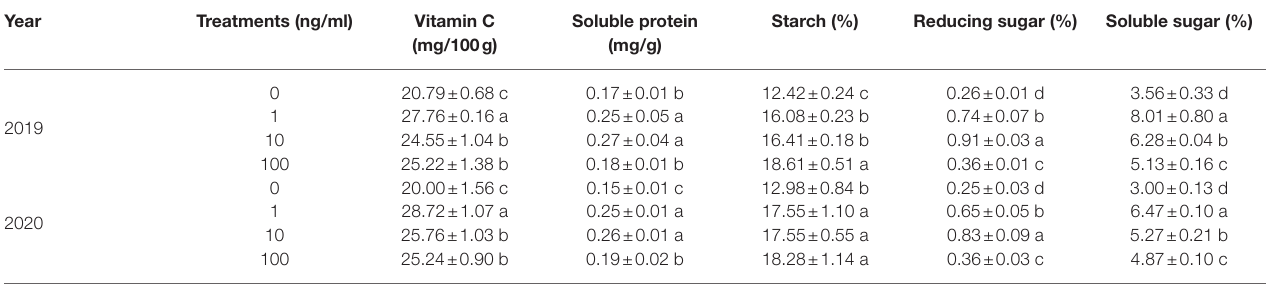
TABLE 3 | Potato quality was influenced by ZNC through irrigation in the field.